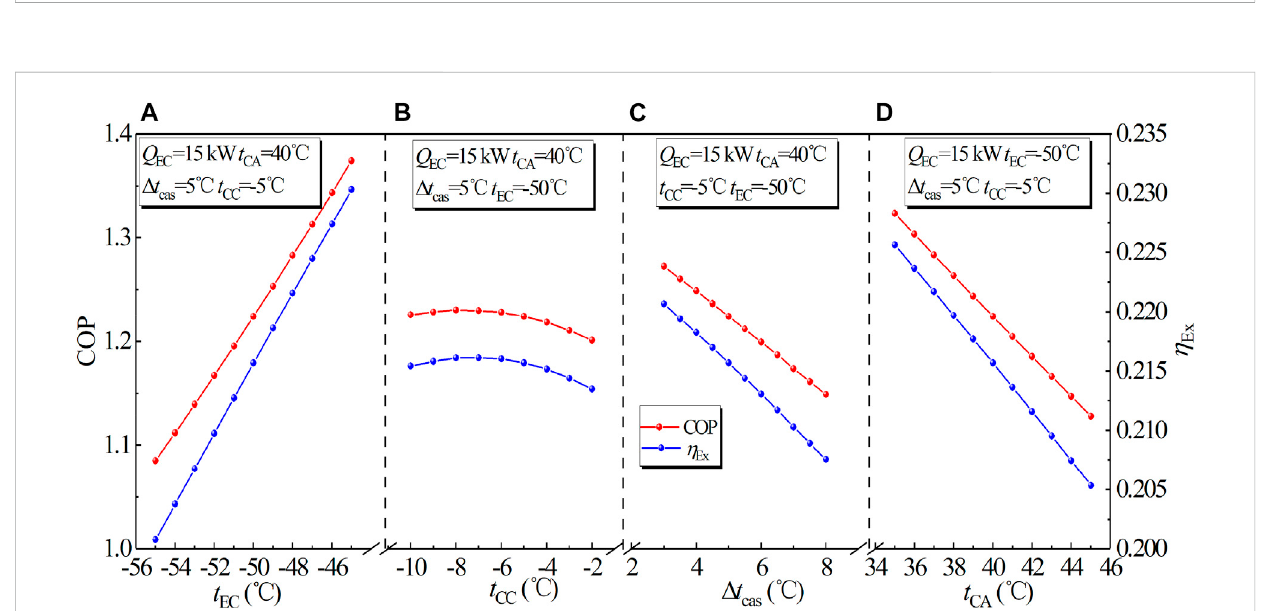
FIGURE 6 VariationofCOPandexergyef fi ciencywithCO 2 evaporationtemperatureandCO 2 condensationtemperature,cascadetemperaturedifferenceand R124 condensation